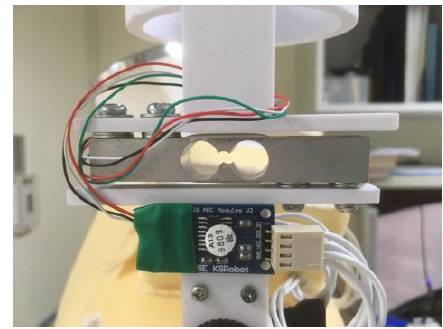
Figure 26. HX711 Electronic Scales.